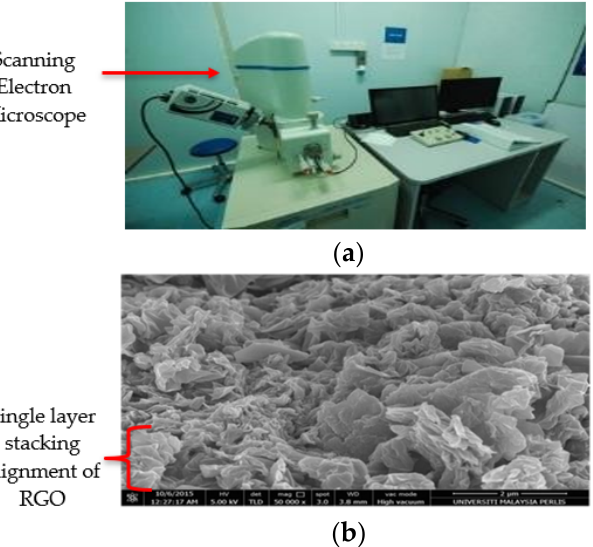
Figure 3. ( a ) Scanning Electron Microscope device ( b ) RGO FESEM image with 50 K of magnifica- tion.